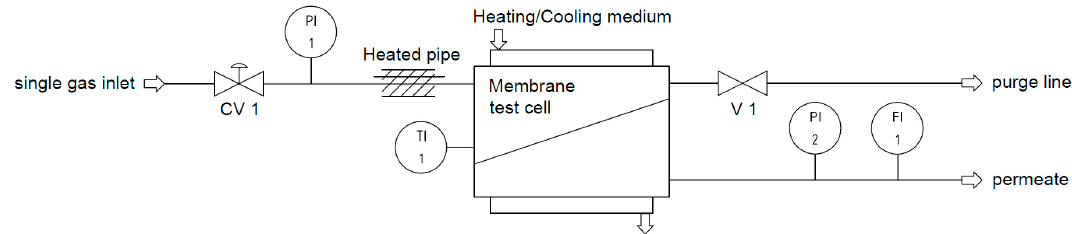
Figure 3. Experimental setup for single gas experiments at high pressures and constant temperature (CV: control valve, FI: flow indicator, PI: pressure indicator, TI: temperature indicator, V: valve).